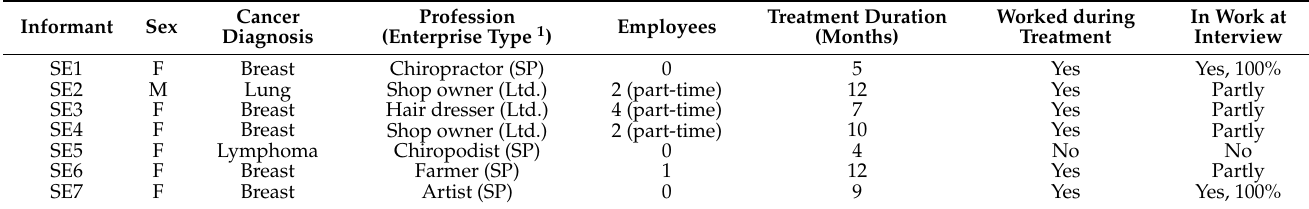
Table 1. Self-employed cancer survivors’ characteristics [22]. Copyright 2021, with permission from Springer Nature. Informant